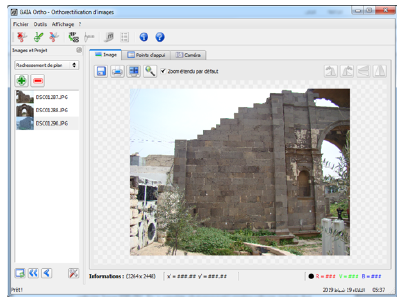
Figure 4. GaiaOrtho free software (Assali,